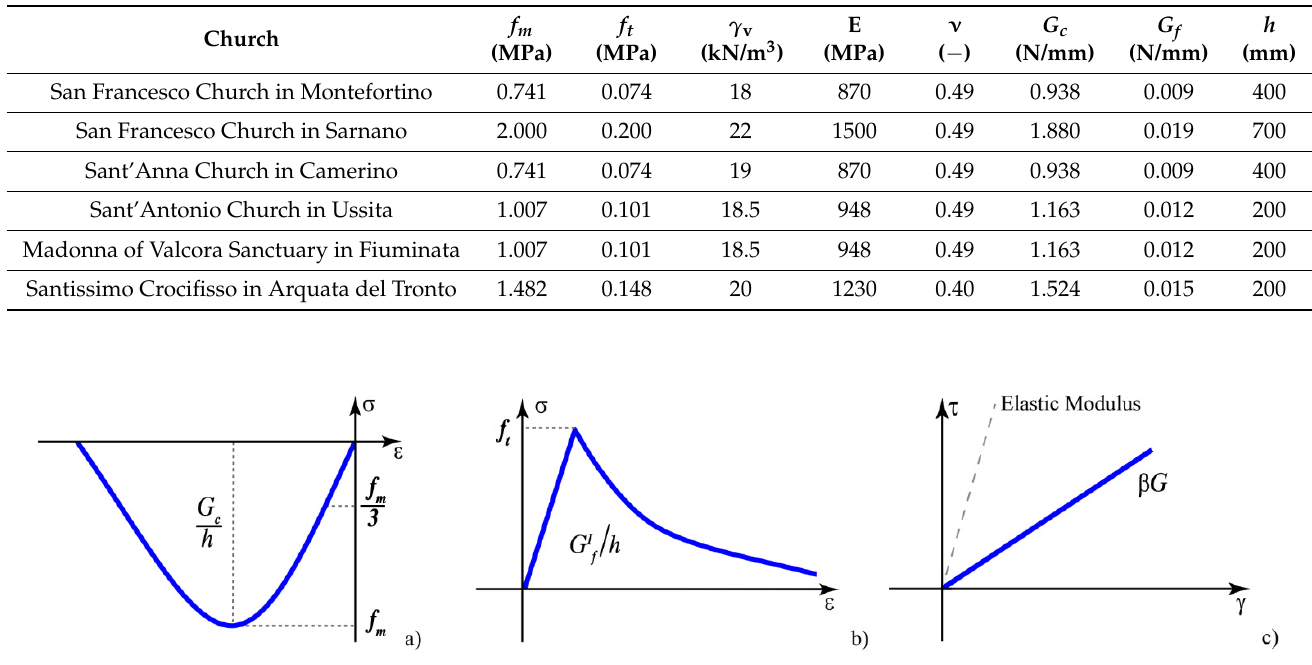
Figure 4. Stress–strain constitutive relations used for the simulations: masonry uniaxial compression ( a ), masonry uniaxial tension ( b ), shear behavior ( c ).